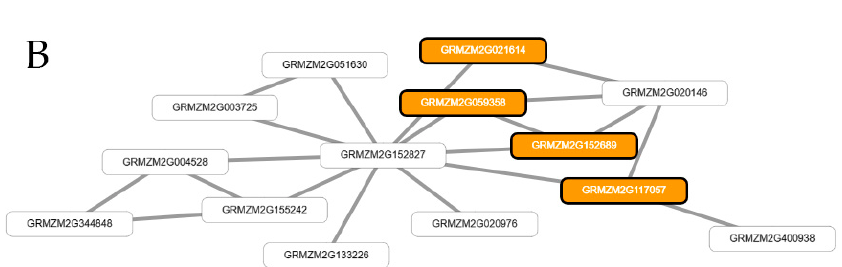
Figure 1. Co-functional networks estimated using genes identified by SNP- and haplotype-based GWAS ( A , B , respectively), genes identified by network-assisted gene prioritization (in MaizeNet) for flowering time and subnets enriched by gene ontology annotations related to the biological processes of female flowering (FF) in MaizeNet. ( A ) Gene GRMZM2G013398 identified by the prioritization analysis (nodes orange highlighted with bold borderline) connected with all the subnetwork genes of MaizeNet (white nodes) and genes associated with the ontology annotations related to flowering time (orange nodes). ( B ) Genes GRMZM2G117057 , GRMZM2G021614 , GRMZM2G059358 , and GRMZM2G152689 identified by prioritization analysis (nodes orange highlighted with bold borderline) connected with all the subnetwork genes of MaizeNet (white nodes).